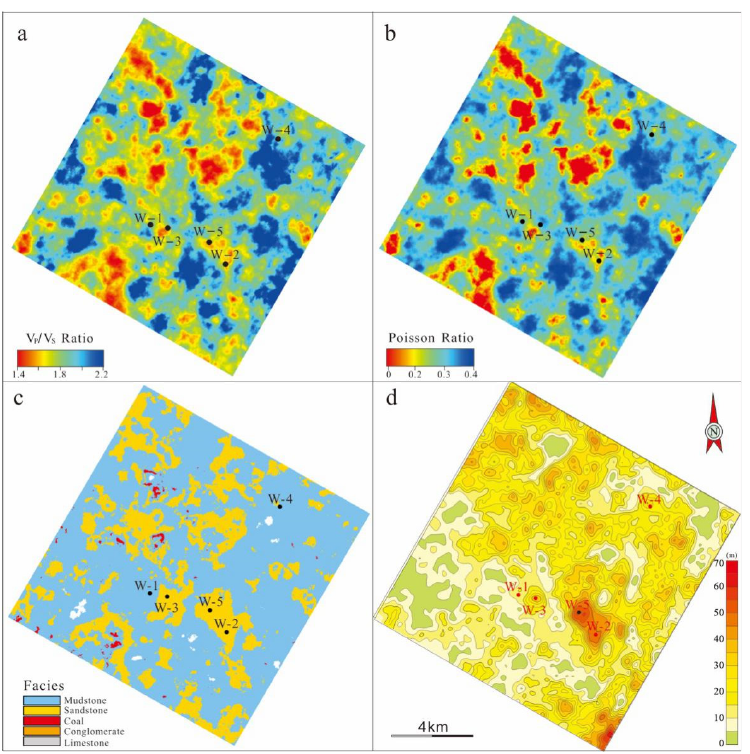
Figure 8. The inverted ( a ) Vp/Vs, ( b ) Poisson’s ratio, ( c ) sand and shale section, and ( d ) the lateral distribution of sandstone in the LST stage of SQ4. Energies 2022 , 15 , 7214